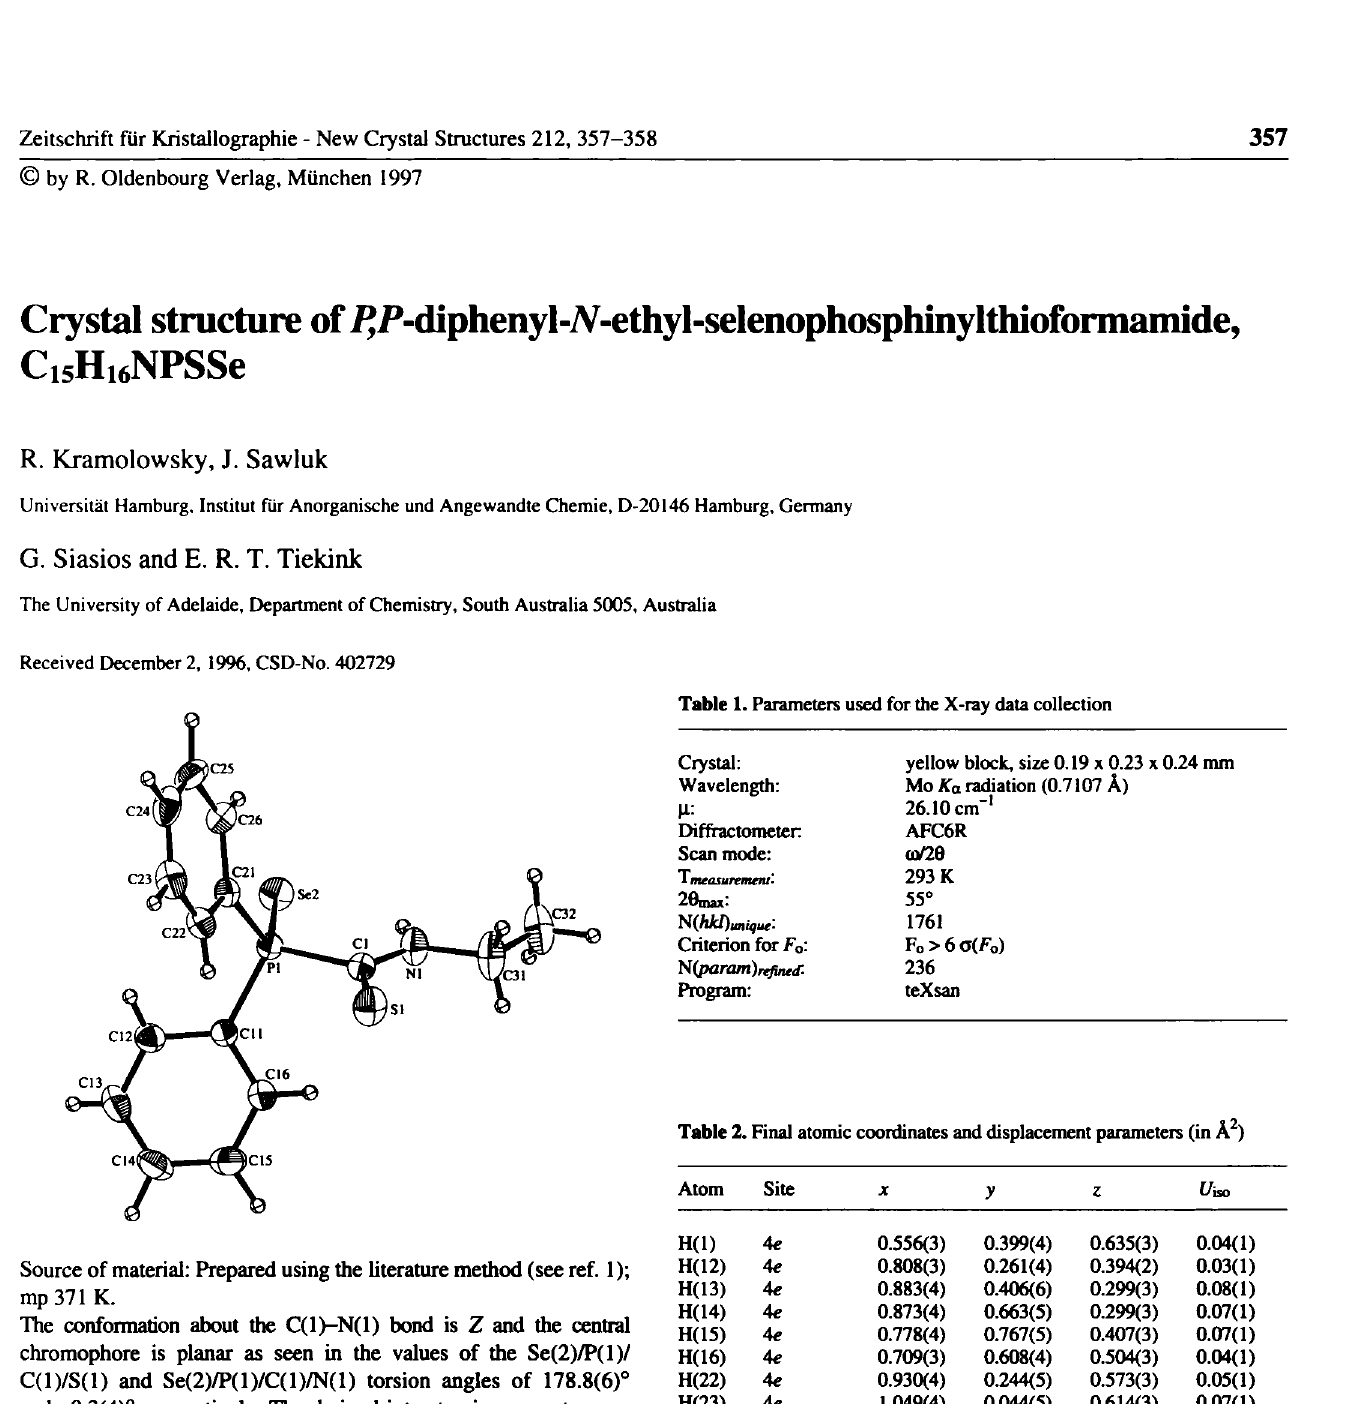
Table 2. Final atomic coordinates and displacement parameters (in Â 2